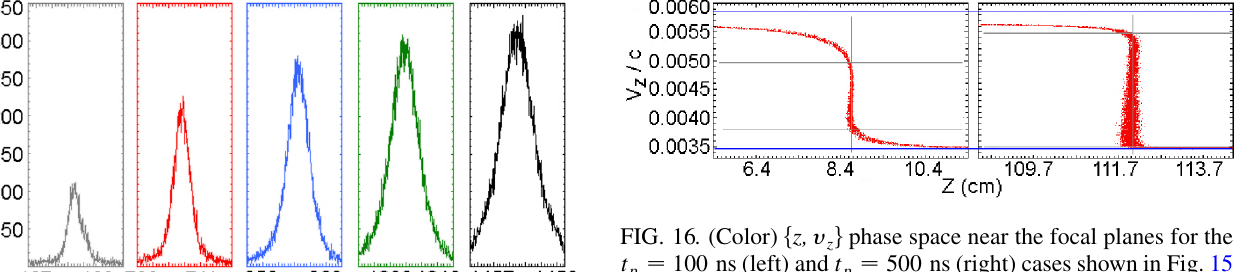
FIG. 15. (Color) Compression ratios I frame at the focal planes using the color-coded smooth wave- forms of Fig. 14 across the finite-size gap for T k (cid:4) 0 : 2 eV , f (cid:4) (cid:4) 100 ns (gray), t 0 : 5 , and t p (cid:4) 400 ns (green), and t (blue), t p